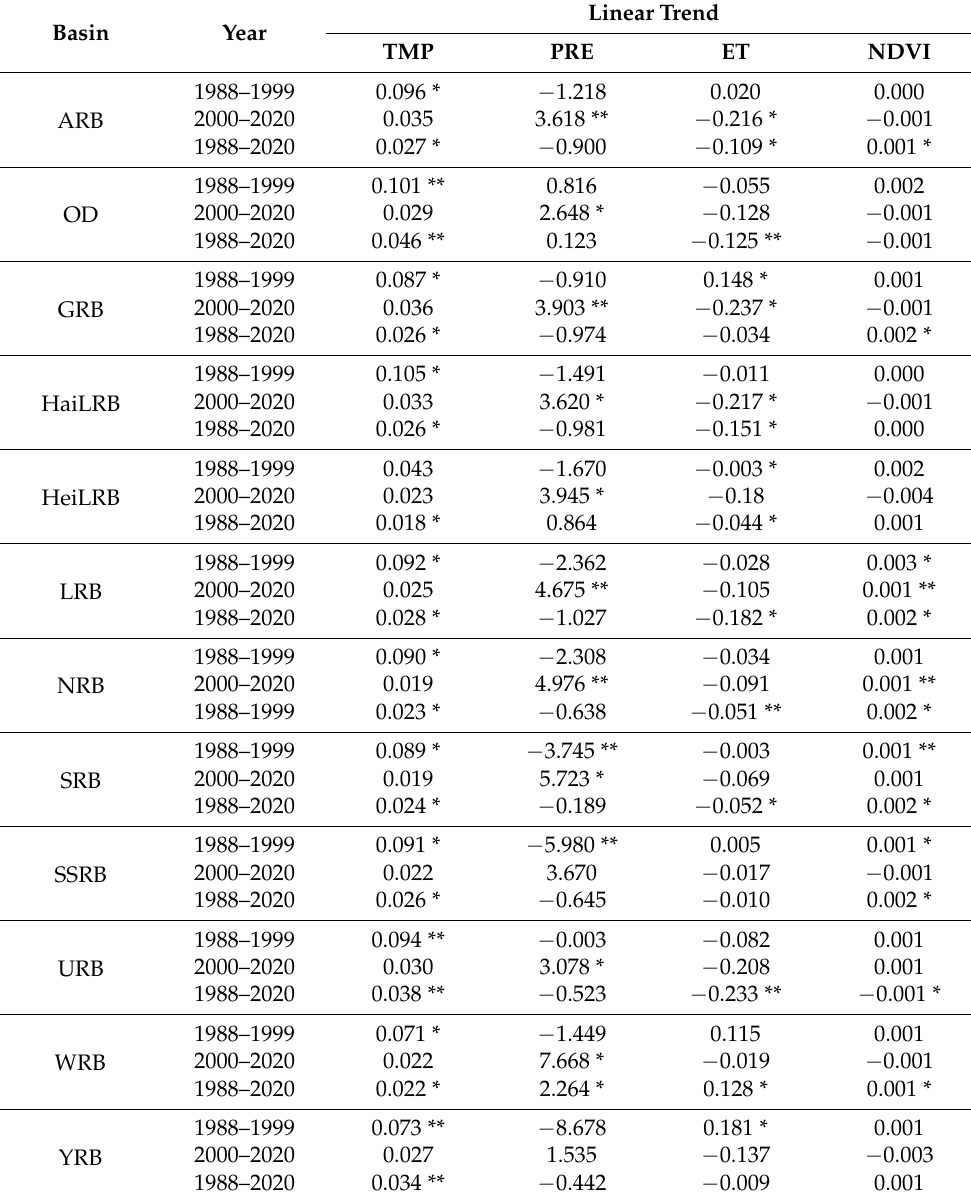
Table 2. The trends of temperature (TMP, ◦ C/year), precipitation (pre, mm/year), evapotranspiration (ET, mm/year), and NDVI (NDVI/year) in each basin of the study area during 1988–1999, 2000–2020, and 1988–2020.